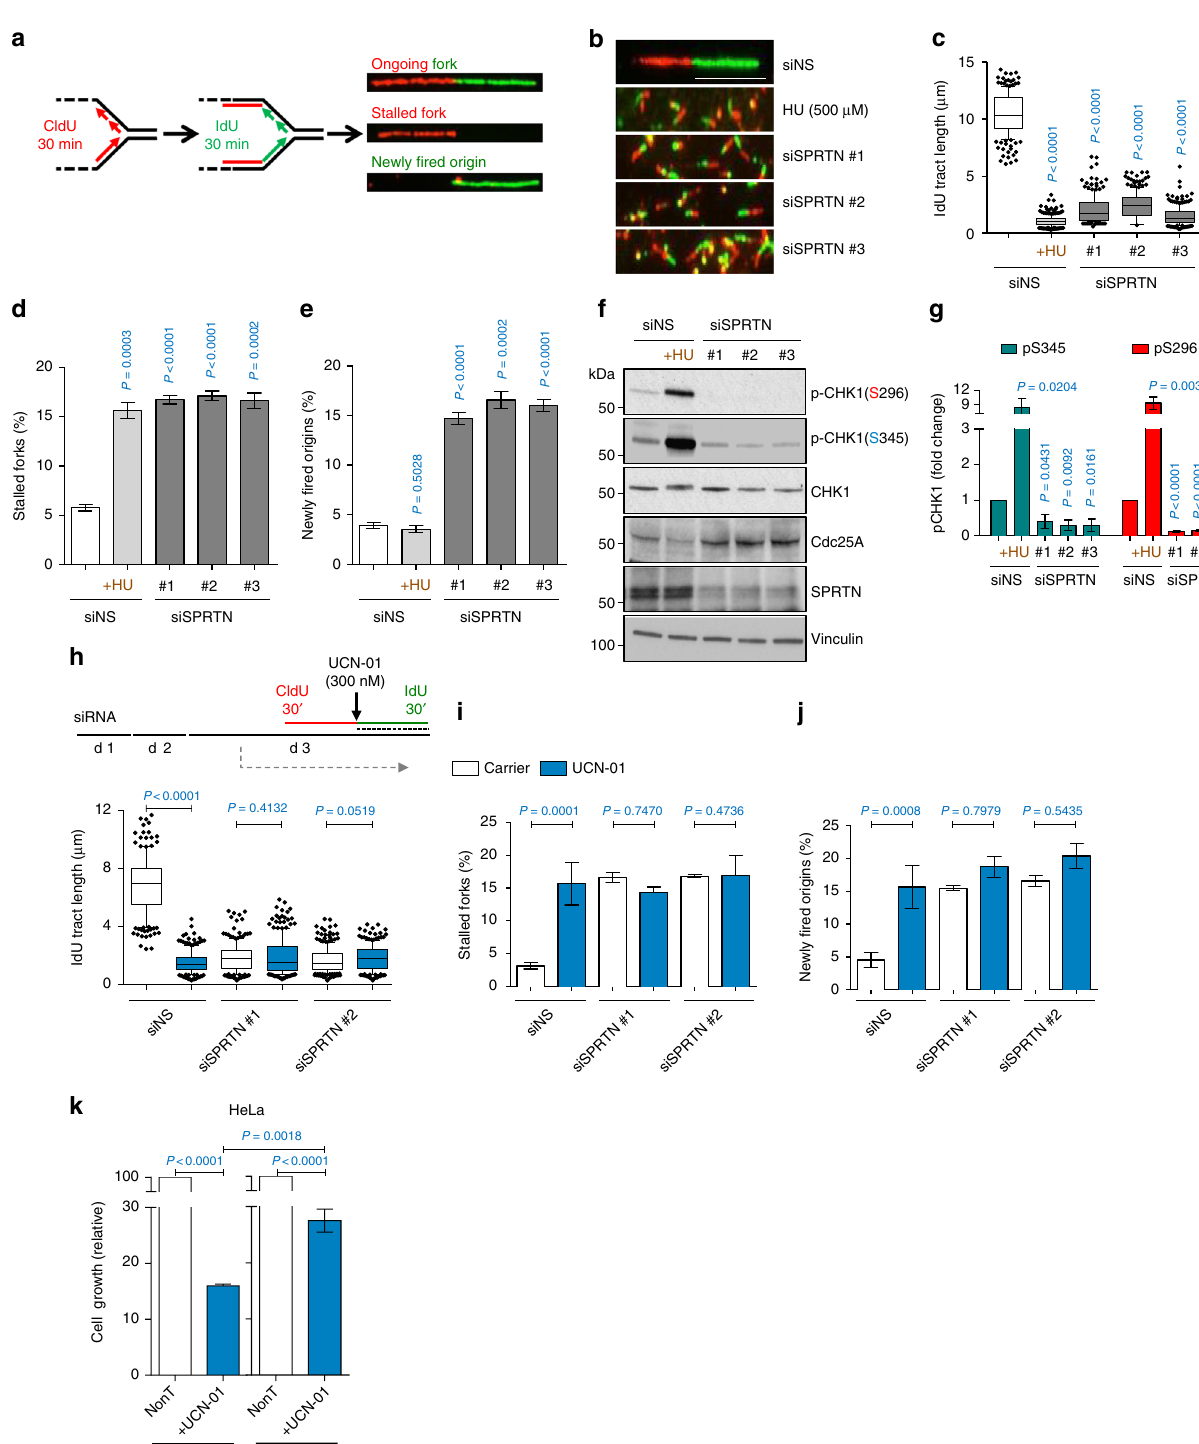
below). These results show that SPRTN-inactivated human cells fail to activate a robust ATR-CHK1 response despite exhibiting CHK1 on chromatin when compared to unchallenged control cells, a similar effect as in cells treated with the